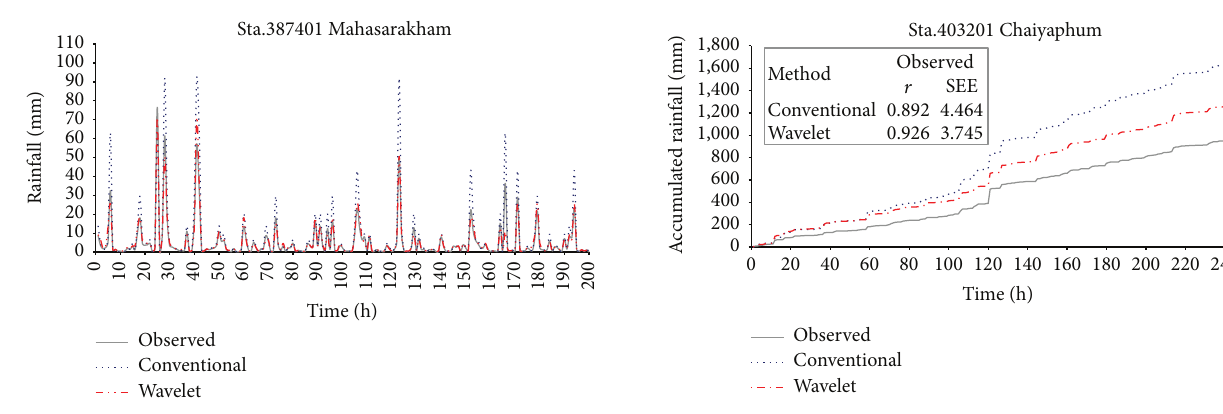
Figure 11: Cumulative observed rainfall data at sta.403201 Chaiya- phum during 1 June–31 October 2011 for verification compared with conventional and wavelet filters technique.